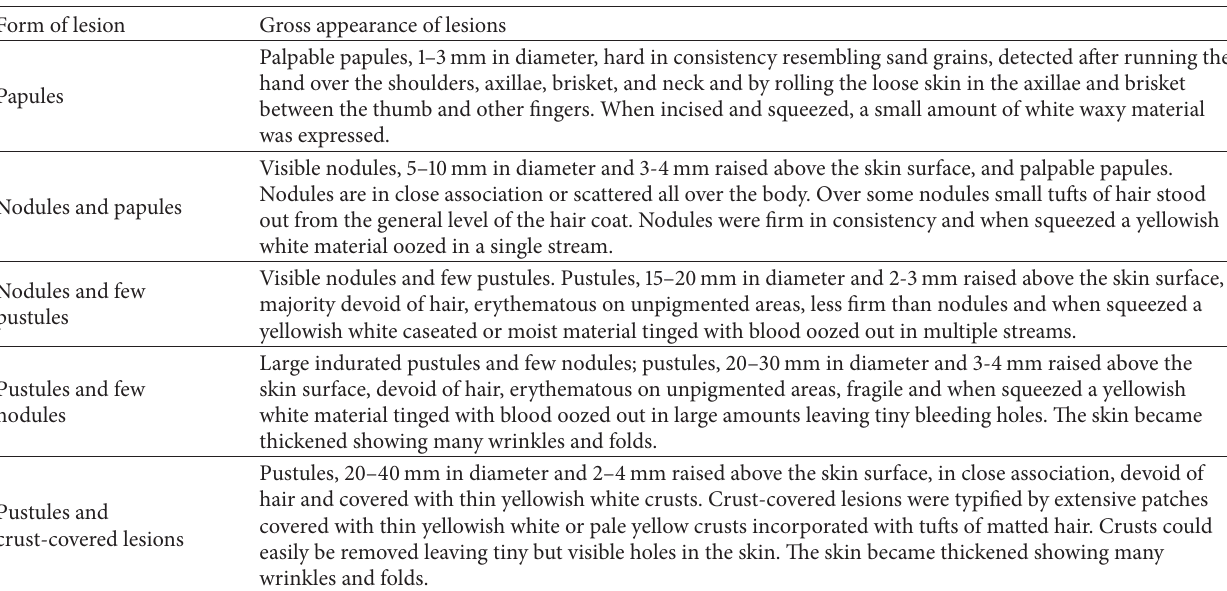
Table 1: Gross appearance of the five forms of skin lesions of demodectic mange in cattle.